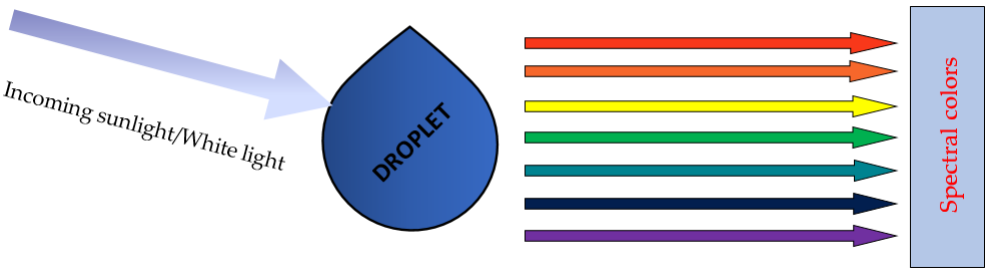
Figure 2. Light dispersion and colors of rainbow.